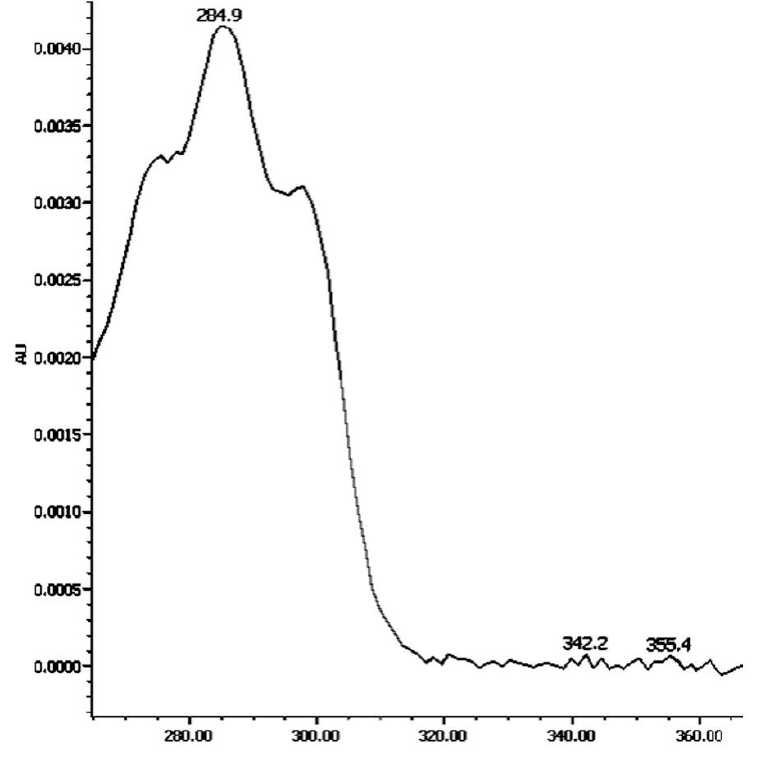
Figure 1. UV-spectra of phytoeneat 285 nm.